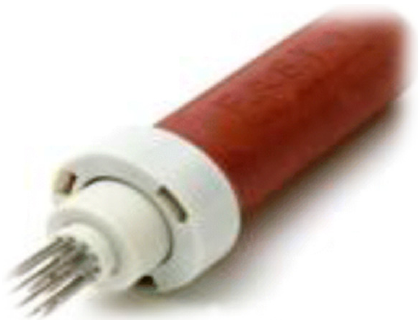
Figure 2. FAST 1 intraosseous device. Source: Pubmed , 2016 (15).